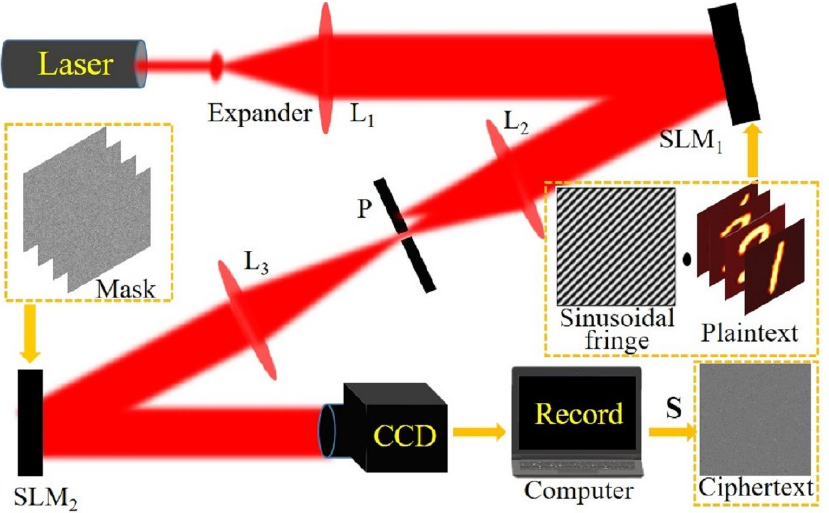
Figure 1. Schematic diagram of multi-image encryption and coding scheme.